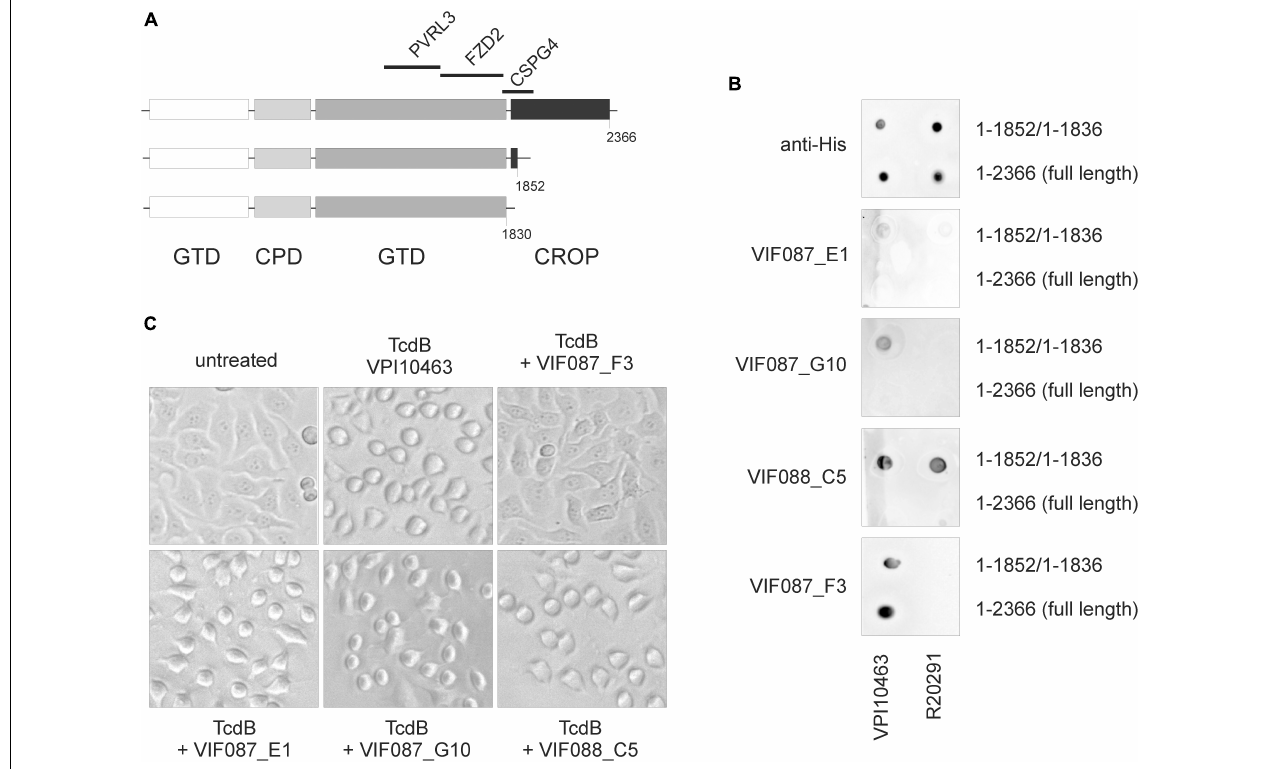
FIGURE 5 | Detection and neutralization of TcdB by specific scFv-Fc. (A) Scheme of TcdB showing deletion mutants and specific receptor binding regions. TcdB 1-1852 does not bind CSPG4, although partial CSPG4 binding region is left. (B) Dot blot analysis of full-length toxins (TcdB VPI10463 1–2366; TcdB R20291 1–2366) and CROP-truncated toxins (TcdB VPI10463 1–1852; TcdB R20291 1–1836) using various scFv-Fc as well as anti-His antibody as positive control under non-denaturing conditions. Full-length TcdB was only detected by ViF87_F3. ViF88_C5 was the only scFv-Fc that recognized epitope in both clade I and clade II toxins, albeit only